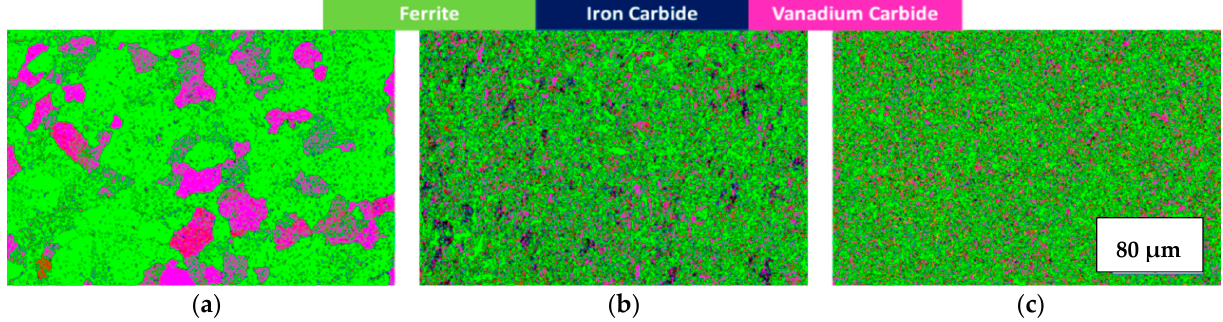
Figure 1. Maps depicting the main phase of studied material: ( a ) untreated, ( b ) heated and ( c ) cryo specimens.